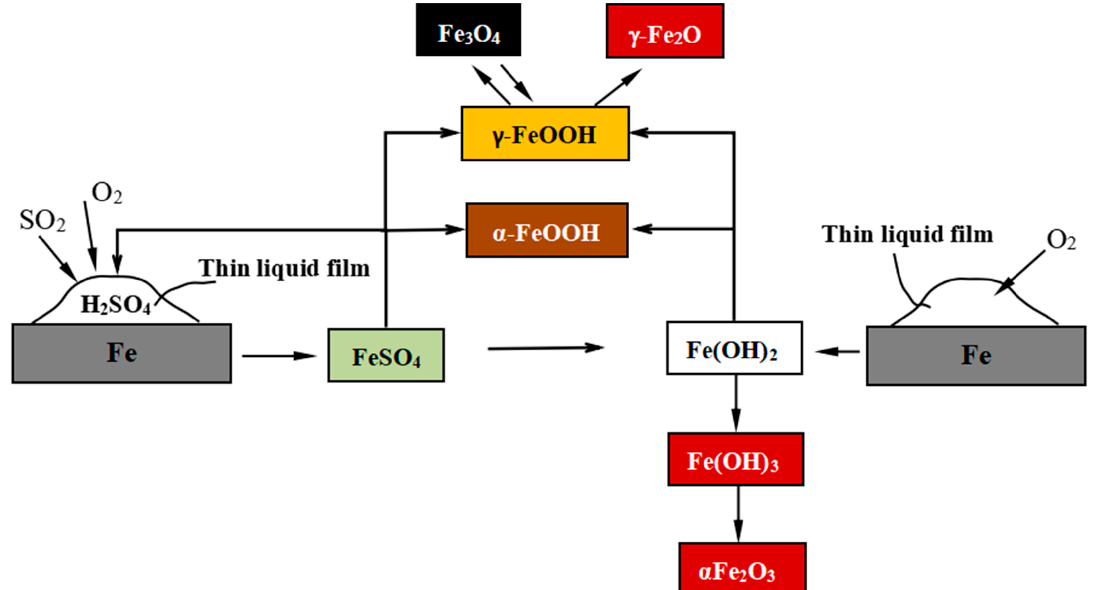
Figure 14. The schematic diagram of the corrosion mechanism.